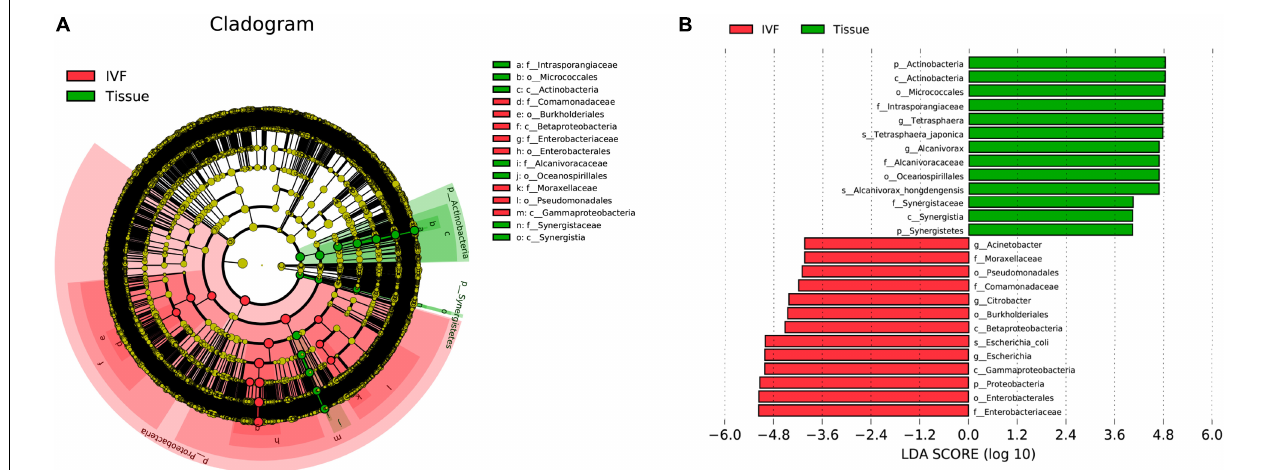
FIGURE 4 | System clustering tree. (A) The red color indicates IVF, the green color represents the tissue. The red nodes represent the key species in the IVF group; the green nodes represent the key species in the tissue group. The yellow nodes represent normal species. The species’ name is on the right side of the figure.